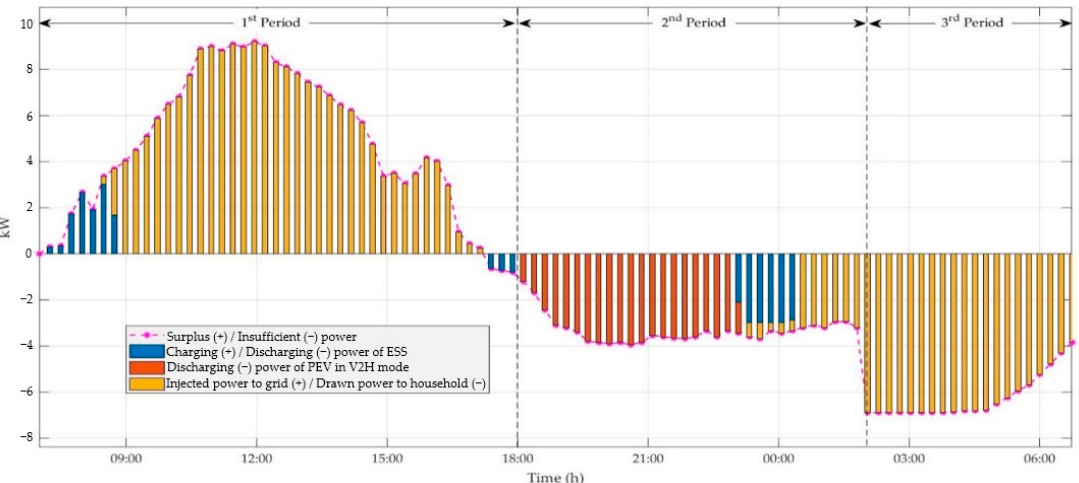
Figure 4. Daily power generation of the solar PV system and household load profile.